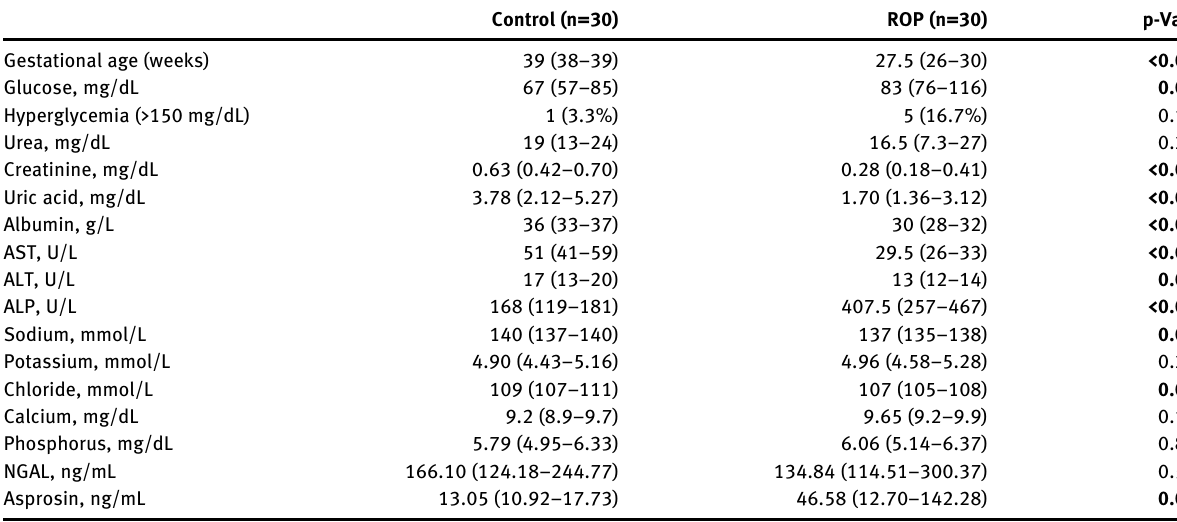
Table  : Demographics and biochemical results of